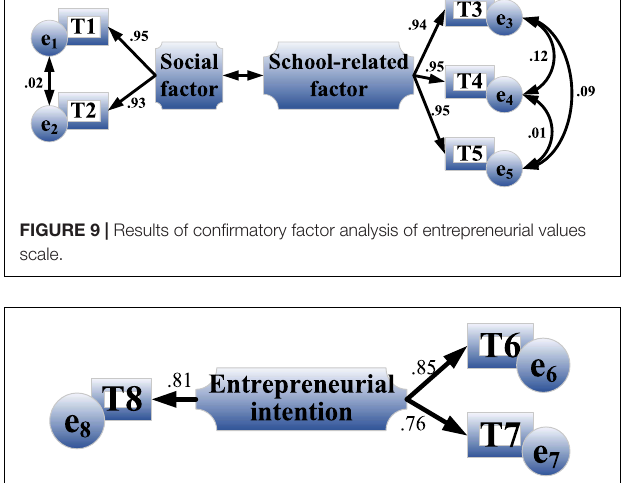
FIGURE 8 | Distribution map of college students’ views on Internet celebrity economy-related cases in the questionnaire.